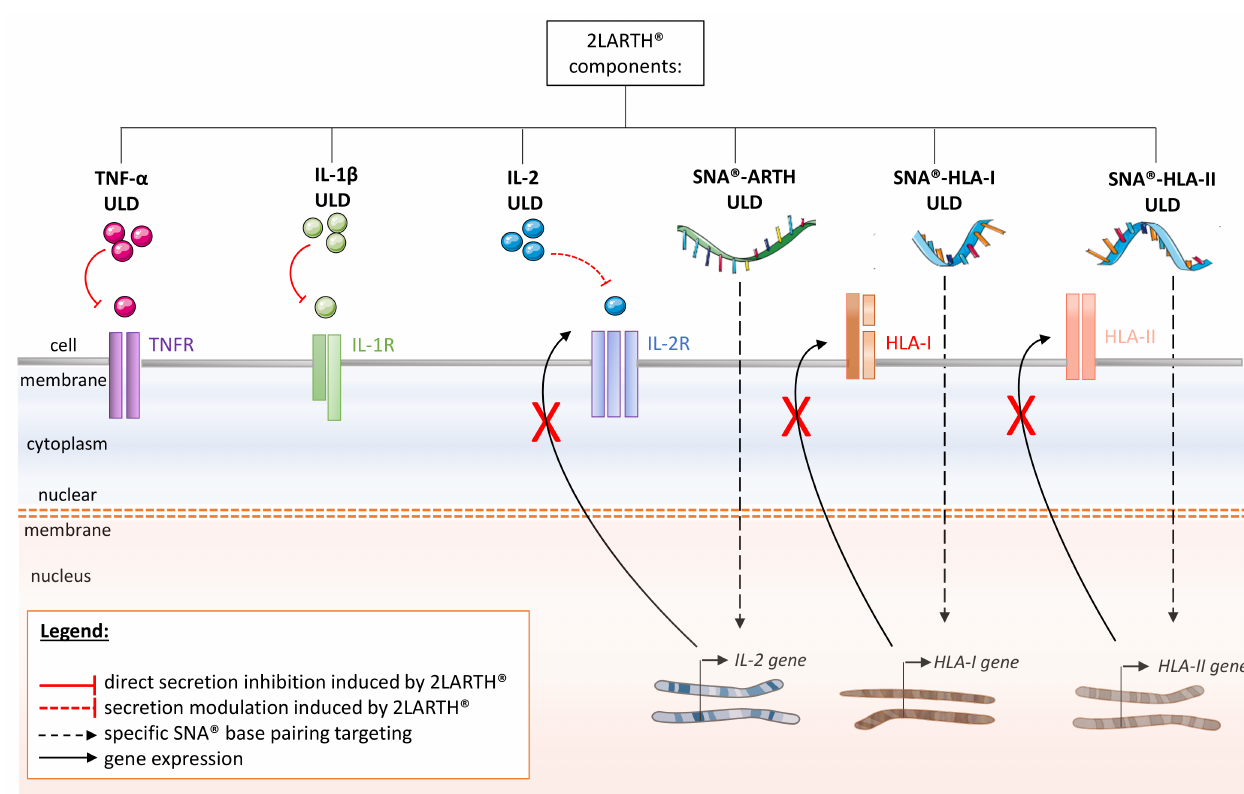
Figure 4. Schematic representation of the multi-targets actions of 2LARTH ® within the cells of the synovial niche in rheumatoid arthritis (RA): HLA: Human leukocyte antigen; IL-1R: Interleukin-1 receptor; IL-2R: Interleukin-2 receptor; SNA ® : Specific nucleic acid; TNFR: TNF receptor; ULD: Ultra-low